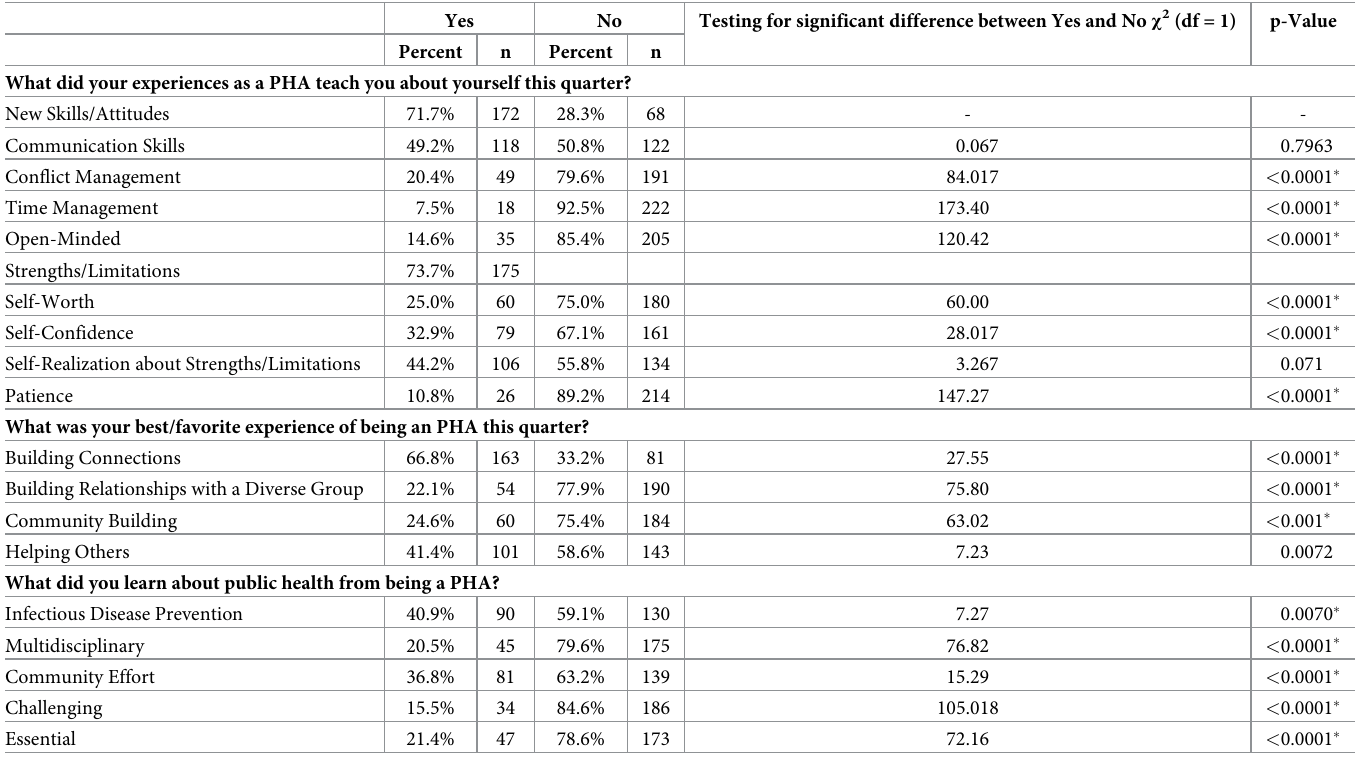
Table 4. Description of PHA